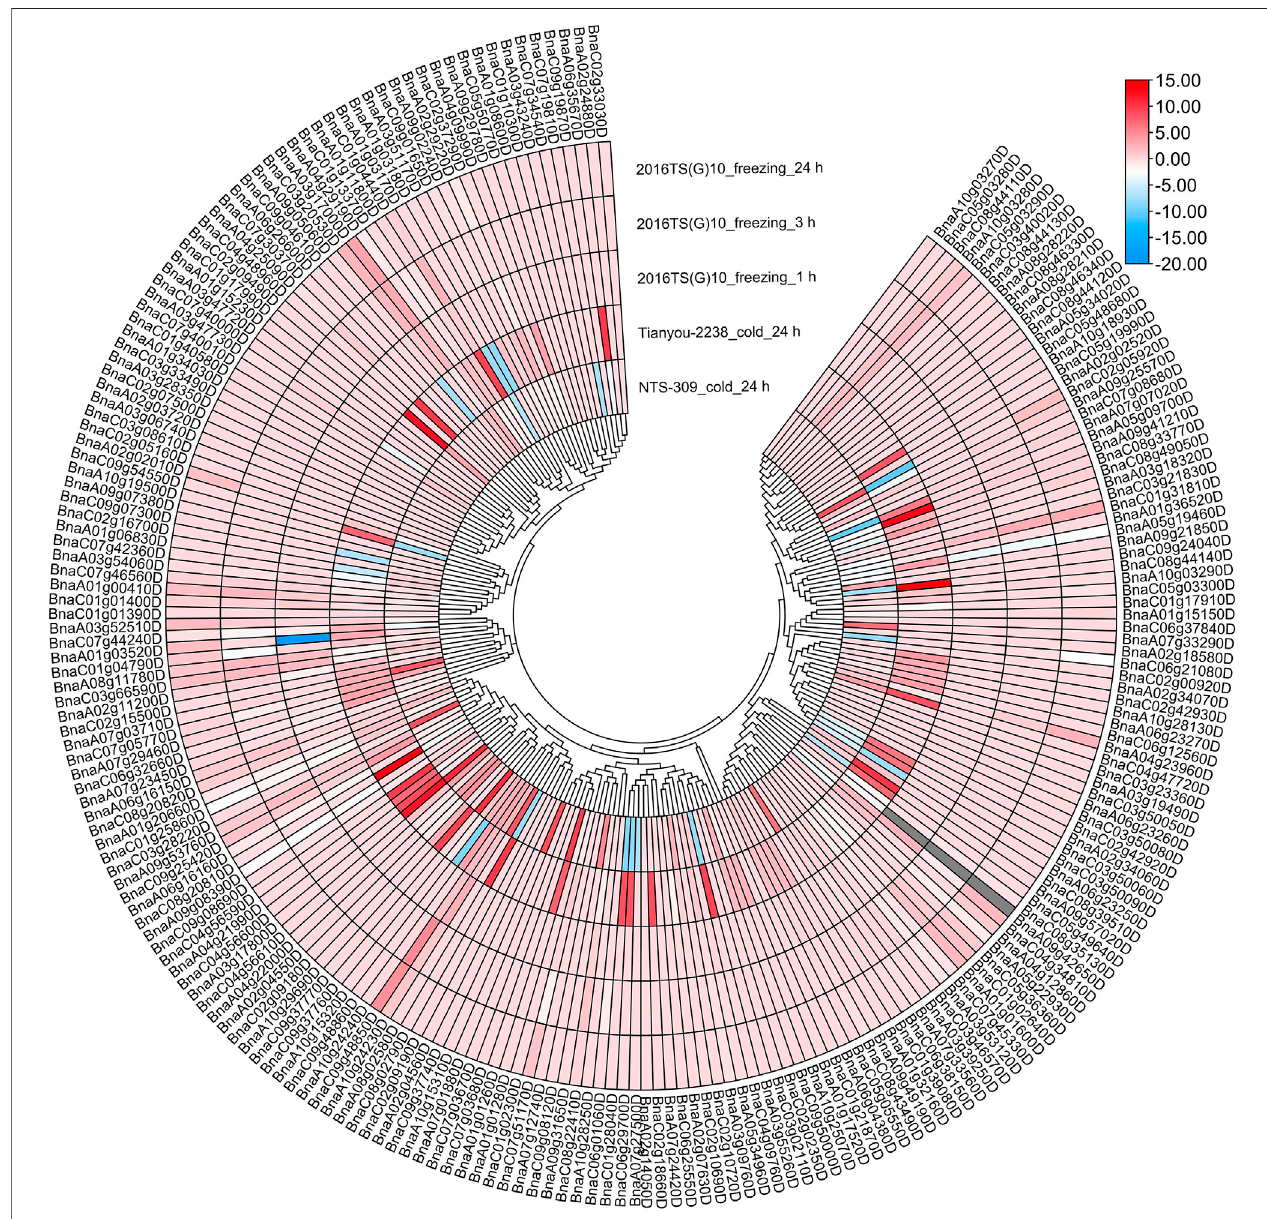
FIGURE7| Theexpressionheatmapof BnAPXs ofdifferentcold-resistantvarietiesunderdifferentstresswasplottedaccordingtothelog2meanofFPKMinRNA-seq.